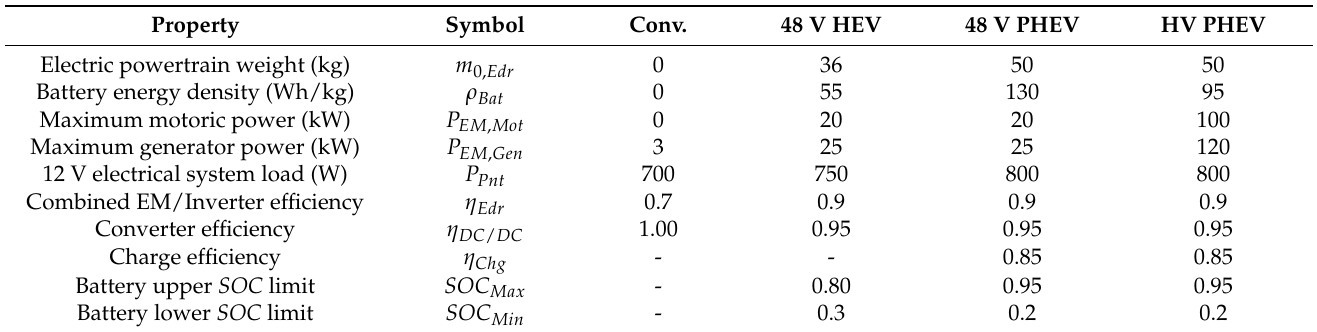
Table 3. Electric powertrain parameters for different degrees of